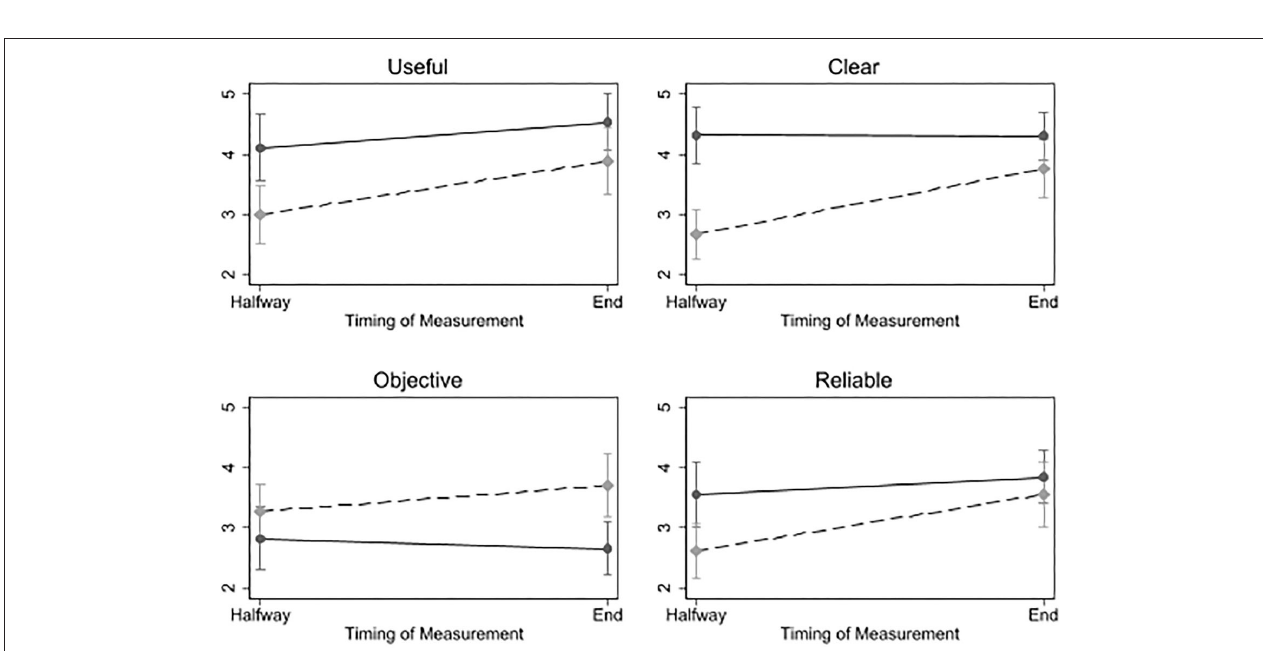
FIGURE 4 | Results of multilevel models, showing coaches’ evaluations of data (a dashed line) and conversation (a solid line), halfway and at the end of the coaching sessions.